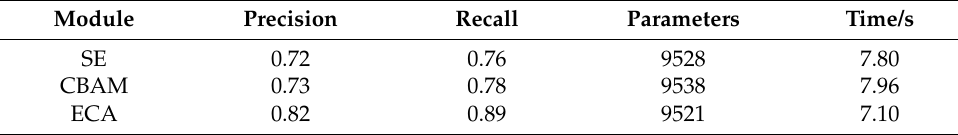
Table 5. Evaluation results of three attention modules in validation.